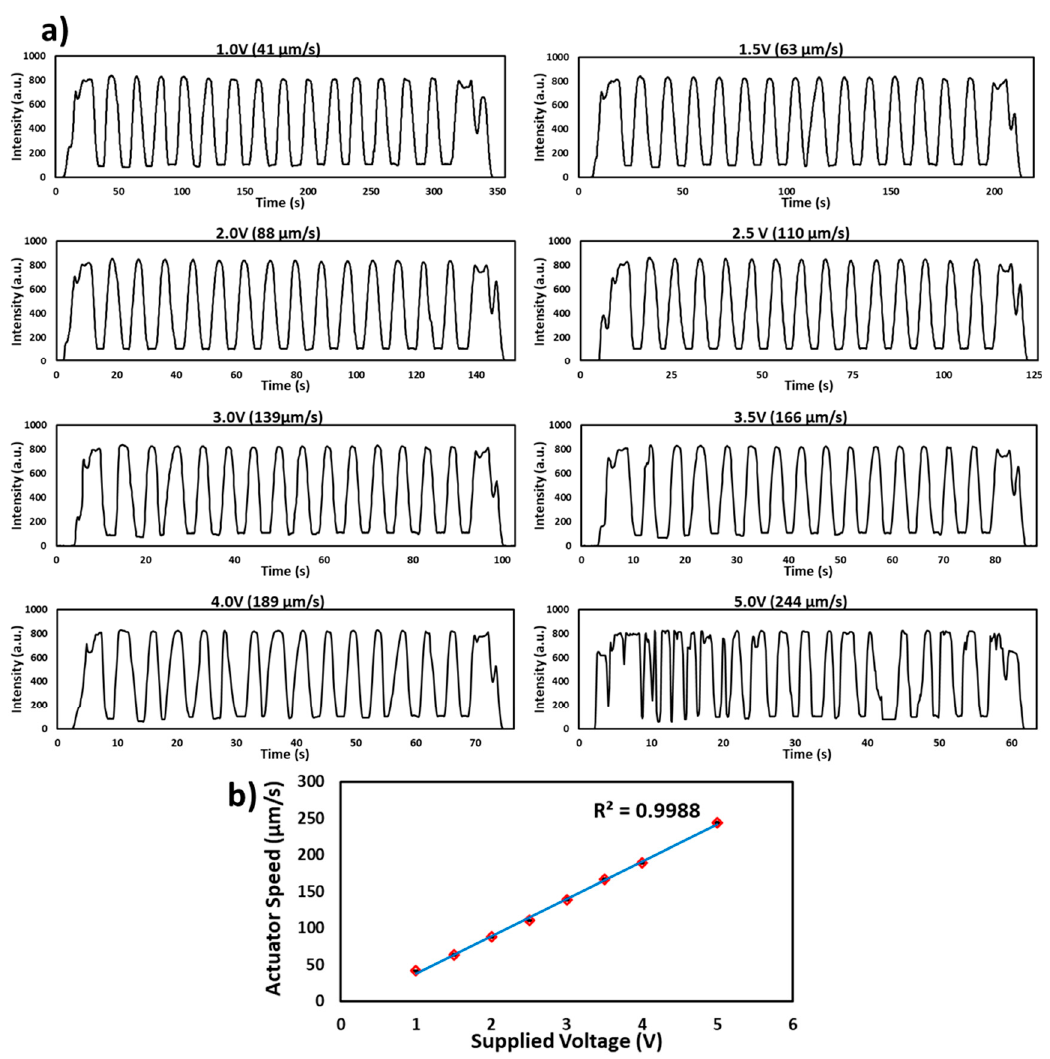
Figure 3. Characterization of the linear actuator. ( a ) Transmitted light intensity profile of the red food dye filled microchip passed through the flow cell at different volts (1.0, 1.5, 2.0, 2.5, 3.0, 3.5, 4.0 and 5.0 V). The signal is stable up to the speed of 189 μ m/s at 4.0 V. ( b ) Graph of the supplied voltage